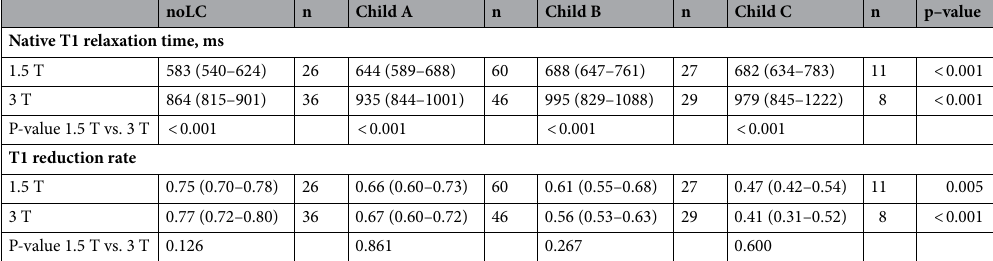
Table 3. Native T1 relaxation times and T1 reduction rates. Values are presented as median and interquartile range (25%-quartile–75%-quartile) or n. P-values of comparisons between T1 relaxation times and T1 reduction rates of 1.5 T and 3 T were calculated using Mann–Whitney U test. P-values of group-comparisons within 1.5 T and 3 T were calculated using the Kruskal–Wallis test. noLC: No liver cirrhosis; Child A, B, C: Child Pugh group A, B, C; IQR: Interquartile Range; ms: milliseconds.